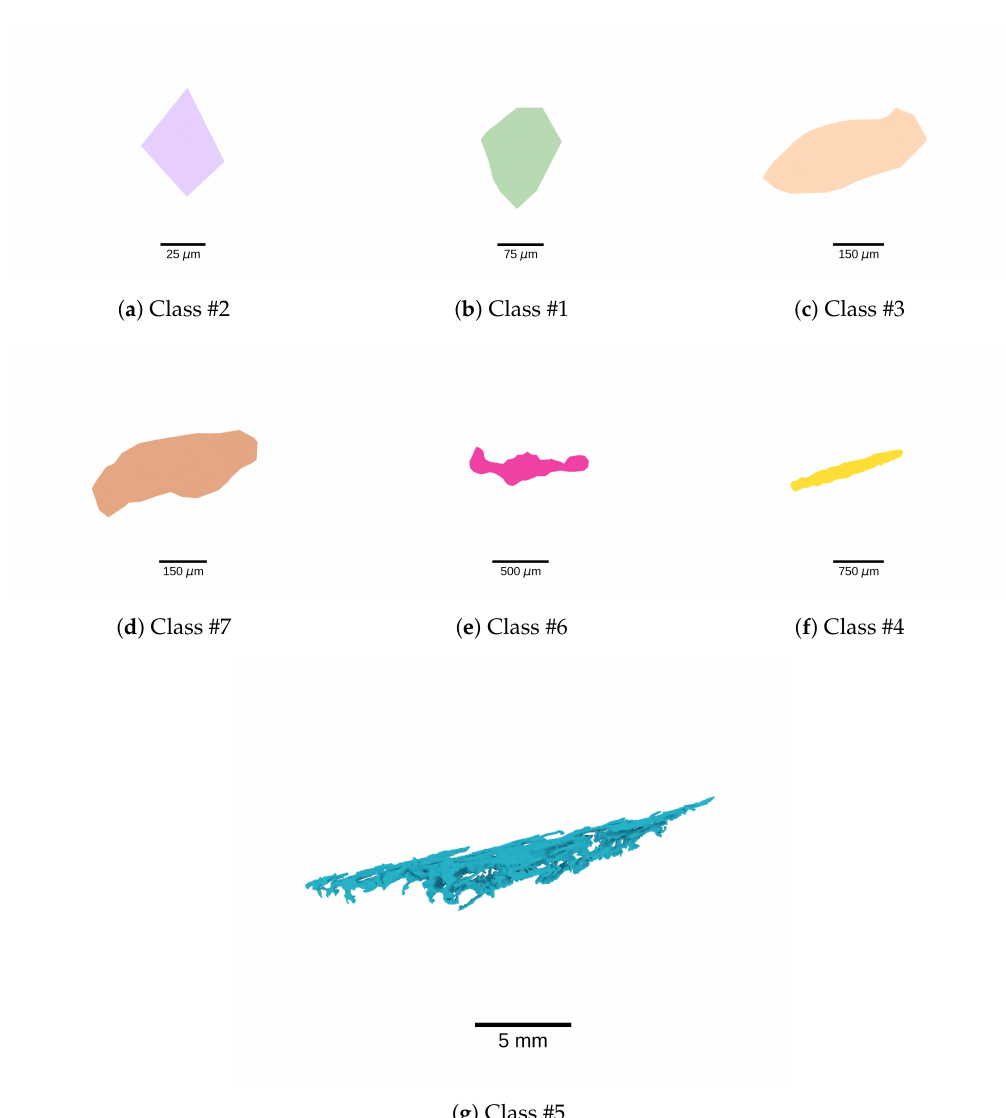
Figure 9. Representative defect morphology from all classes ordered by size. Note that the scale differs between